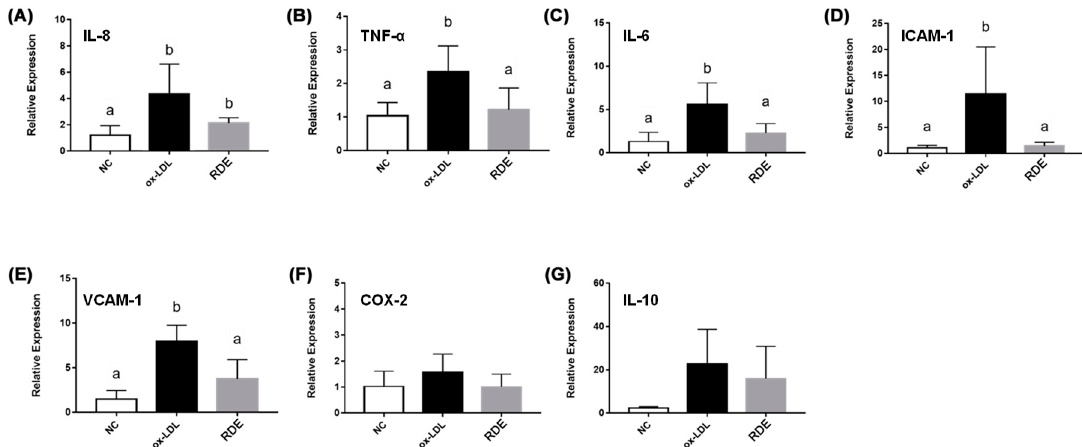
Figure 10. Gene expression of inflammatory mediators in no treatment (NC), ox-LDL treated (ox-LDL), or RDE then ox-LDL treated EA.hy926 cells in the Caco-2 BBe1 / EA.hy926 co-culture model. Caco-2 BBe1 cells on the apical compartment were supplemented with 100 µ g / mL RDE for 1 h, followed by an incubation of 100 µ g / mL ox-LDL on the EA.hy926 cells for 6 h. The gene expression of ( A ) IL-8, ( B ) TNF- α , ( C ) IL-6, ( D ) ICAM-1, ( E ) VCAM-1, ( F ) COX-2, and ( G ) IL-10 are shown. Values are presented as means ± SEM, n = 4. Shared letters indicate no significant di ff erence ( p > 0.05).